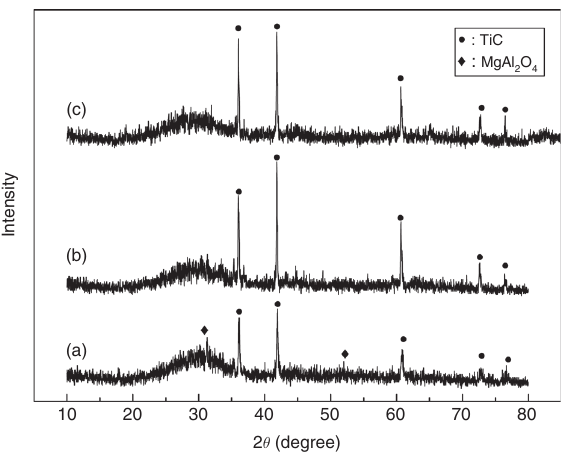
Figure 14: XRD results of reduced samples with carbon ratio of 1.0, for 4 h at different temperatures: (a) 1,673 K; (b) 1,773 K; (c) 1,873 K